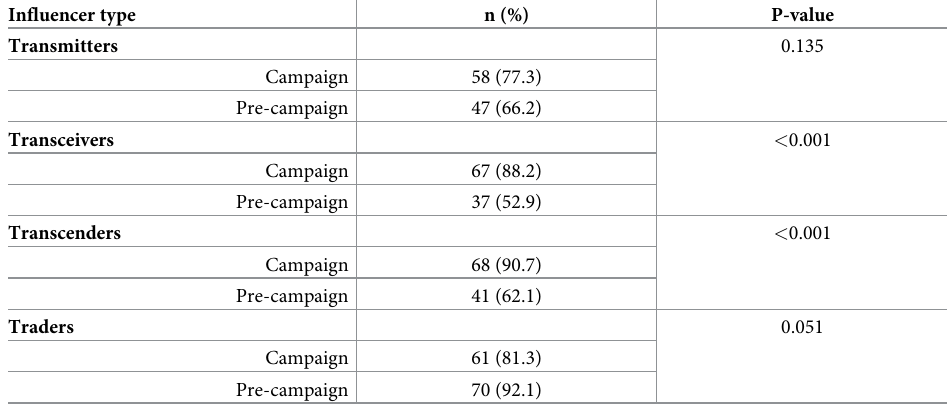
Table 3. Differences in the percentage of Twitter influencers from the scientific community between the cam- paign network and the six-months network; 2020 World Breastfeeding Week.